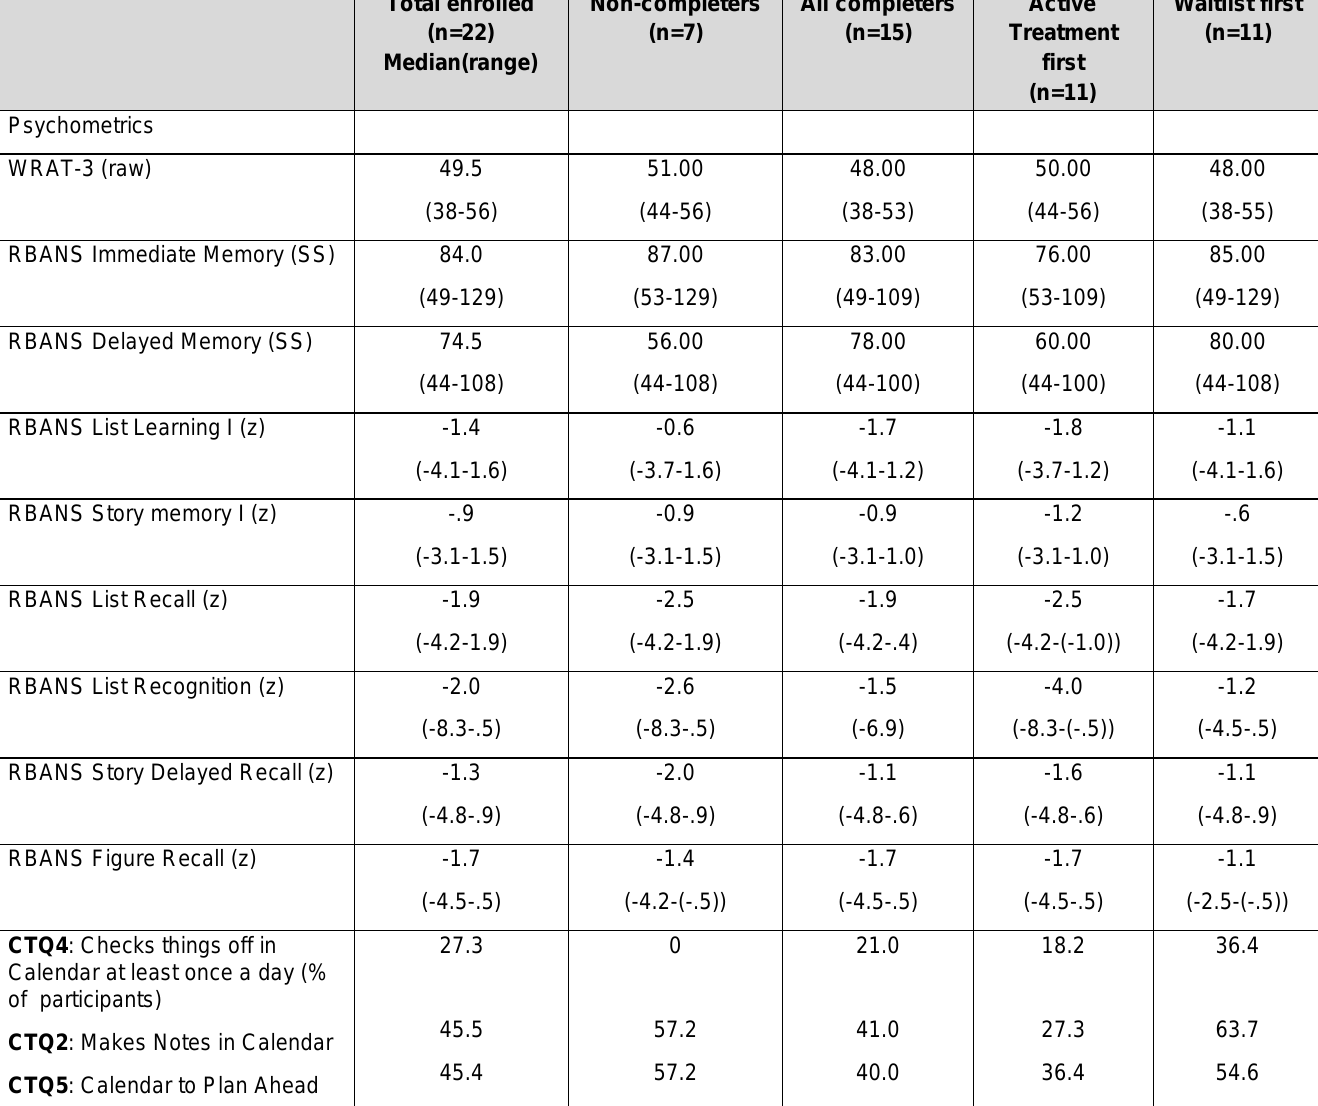
Table 2. Descriptive Summary of Memory Performances and Compensation Use at